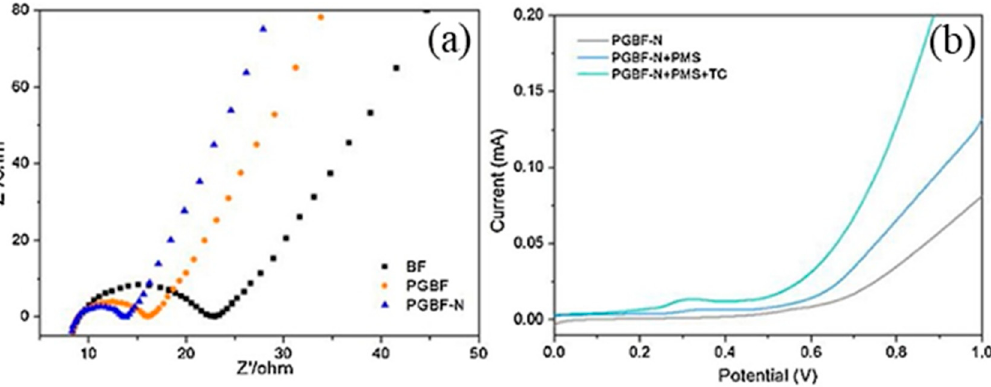
Figure 7. ( a ) EIS measurement of biochar-based catalysts and ( b ) LSV under different conditions